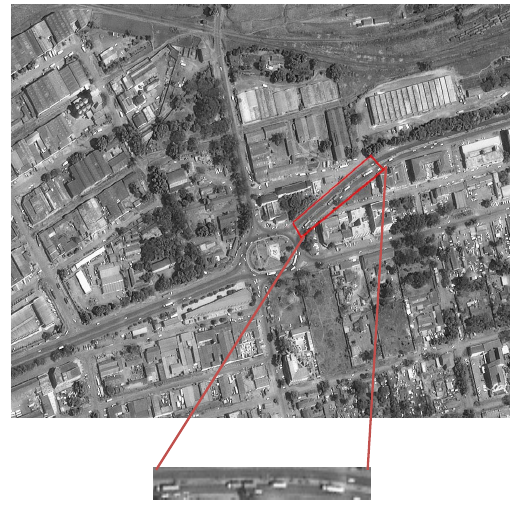
Figure27: IKONOS Grayscale Image (0.8m) & ROI